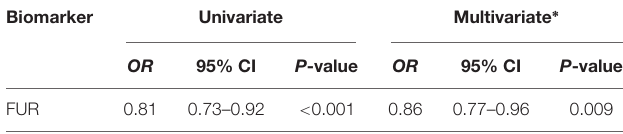
TABLE 3 | Relationship between POTS status and selected biomarker in univariate and multivariate